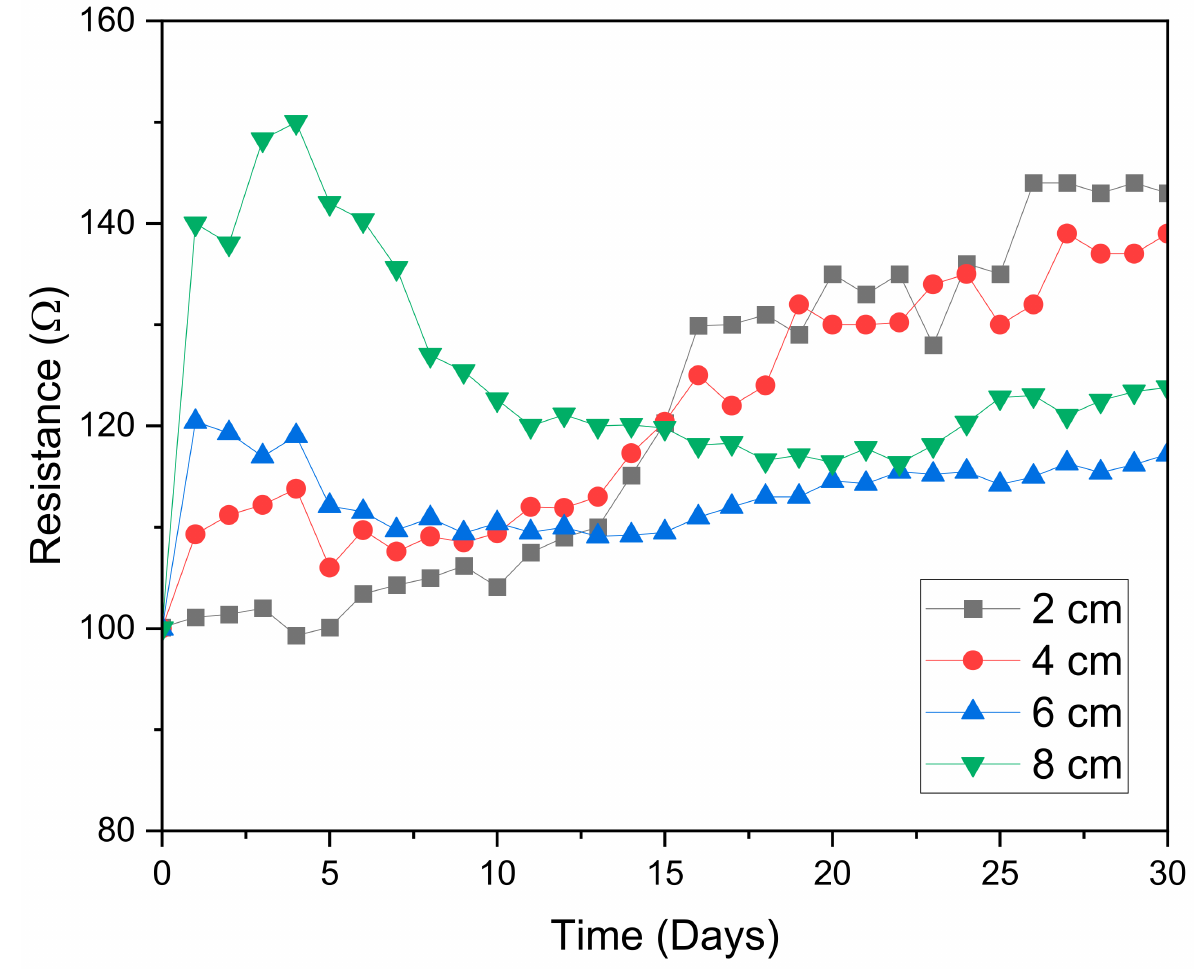
Figure 4. Variation in total resistance with